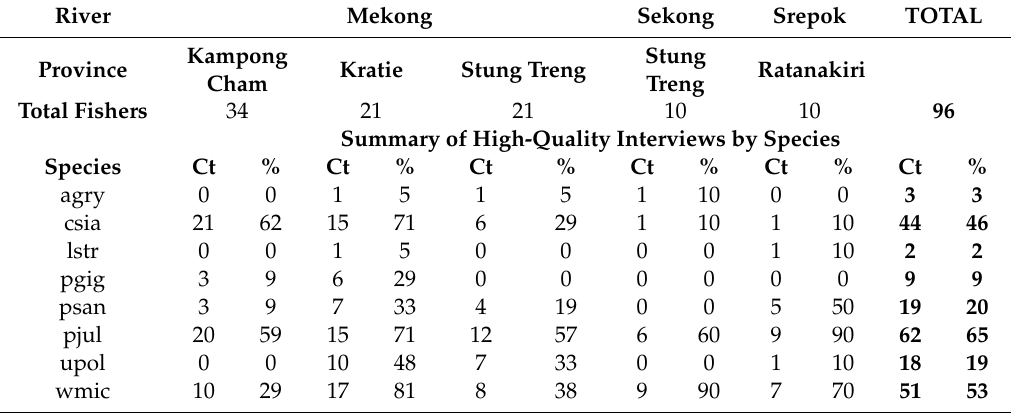
Table 3. Summary of high-quality interviews by river section and species. For the summary by species, “Ct” columns show the count (number) of high-quality interviews for each species in each river section. The “%” columns show the proportion of fishers from each river section who provided a high-quality interview on each species. Thus, a larger value in the “%” column indicates more fishers were knowledgeable about that species than other species. For species abbreviations, see Table